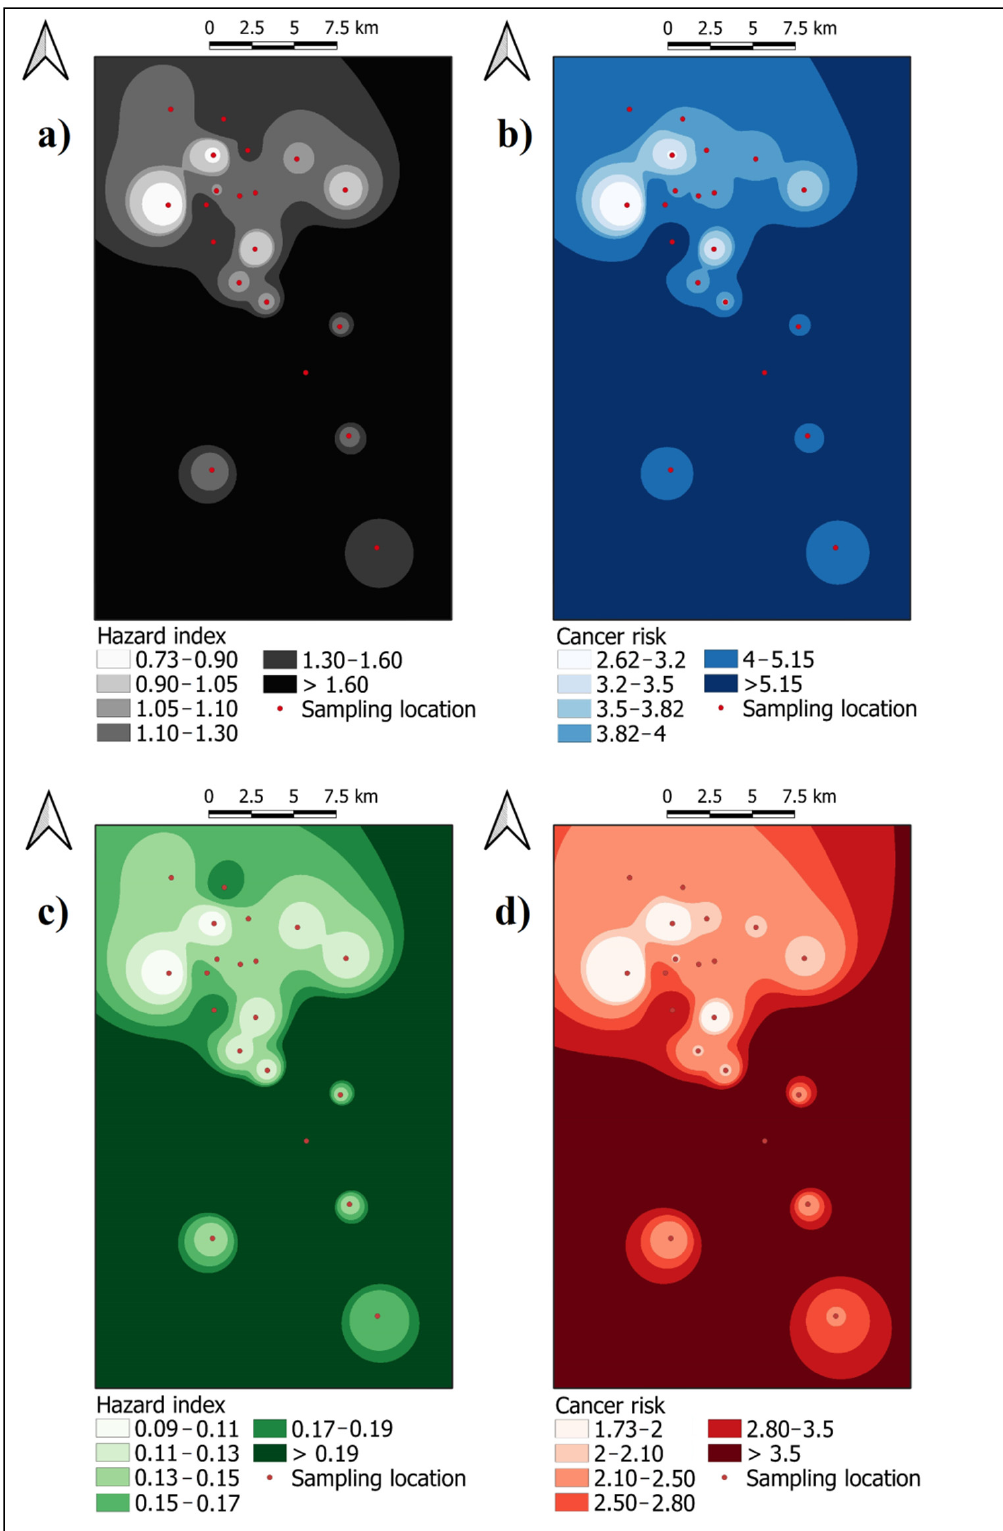
Figure 5. Total hazard indices (As + Cr + Cu + Ni + Pb + Zn + Cd) and total cancer risks (As + Cr + Ni + Pb) for children ( a , b ) and adults ( c , d ).